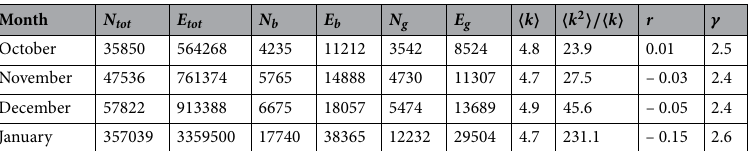
Table 1. Size of the monthly user-user interaction networks. The subscript tot stands for the unfiltered data, b for the backbone extracted with the disparity filter, g for the largest connected component of the graph. Network statistics reported for these latter networks are the average degree (cid:31) k (cid:30) , the average excess degree (cid:31) k 2 (cid:30) / (cid:31) k (cid:30) , the assortativity coefficient r and the slope of the degree distribution γ ≃ − ln P ( k )/ ln k (fitted starting from k min = 10